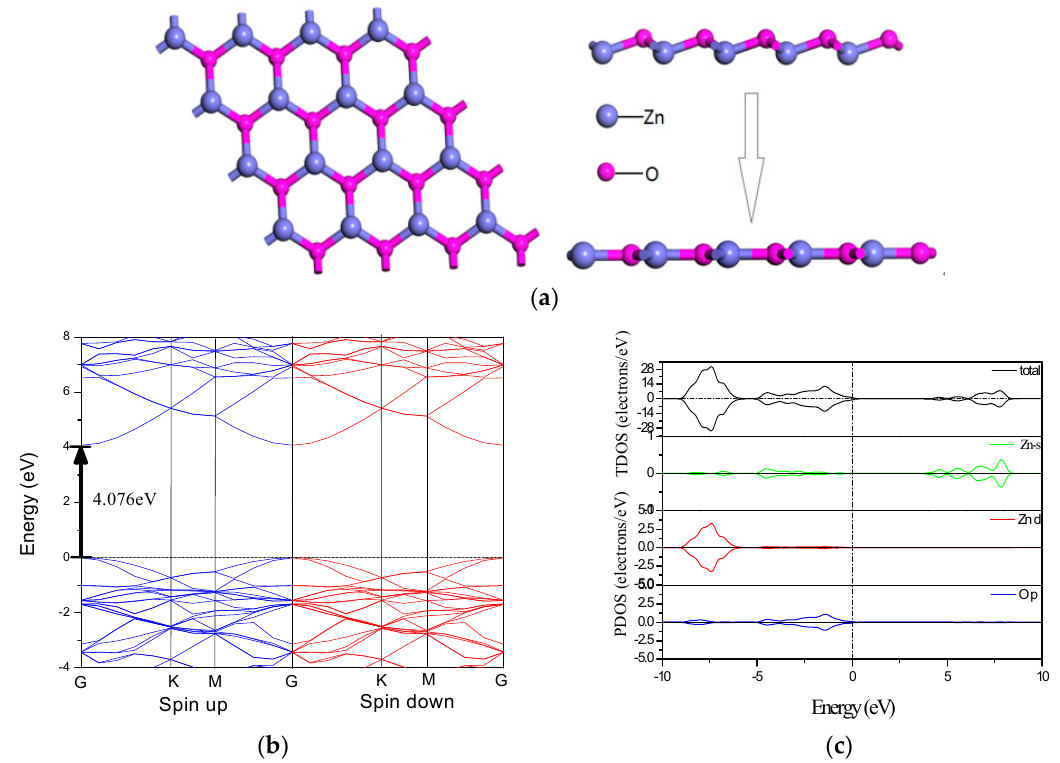
Figure 1. The structural and electronic properties of pristine ZnO monolayer: ( a ) relaxed structure; ( b ) band structure; ( c ) DOS.